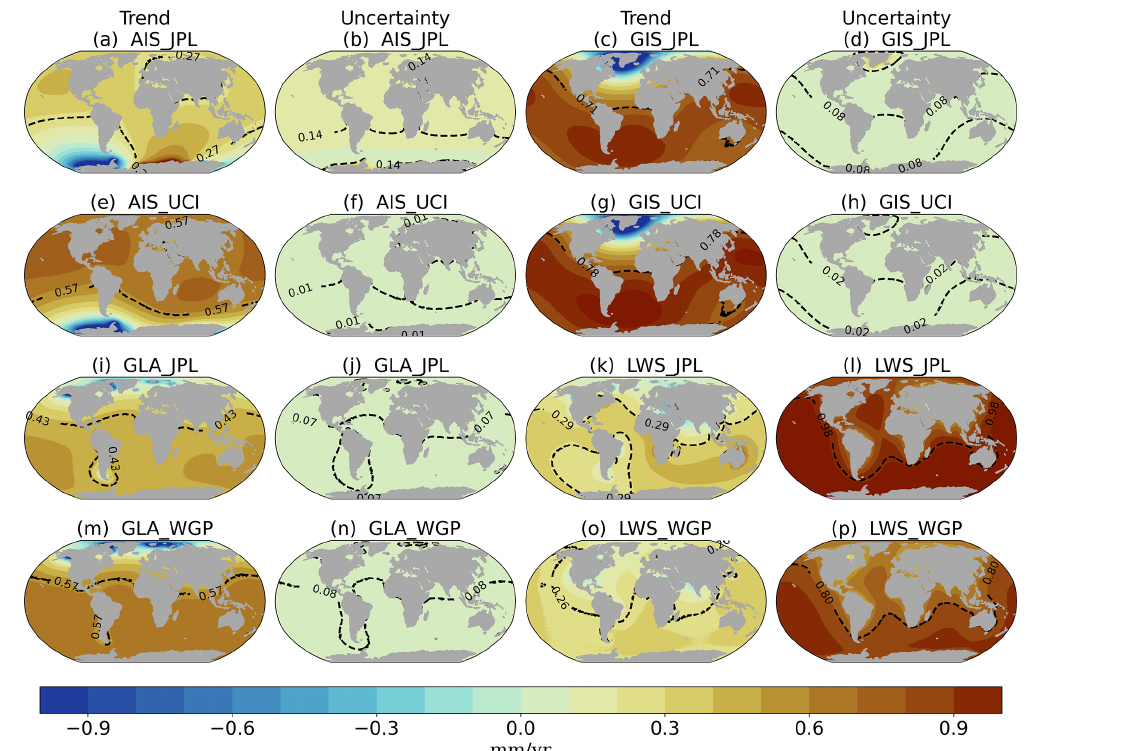
Figure 4. GRD-induced sea-level trend and temporal uncertainty (mmyr − 1 ) for GRACE (JPL) and independent combination (UCI + WGP) for 2003–2016. The black dashed contour line and number indicate the spatial average of the regional trend and uncertainty. Trends and uncertainties of CSR, IMB, ZMP and GWB presented in Supplement Fig.